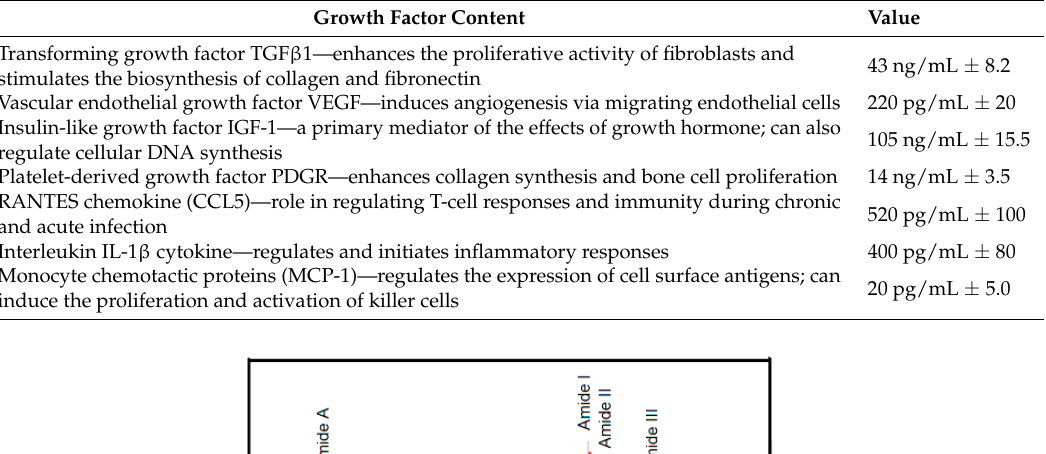
Table 2. Quantitative assessment of the main growth factors, cytokines, and chemokines in PRGF fraction.